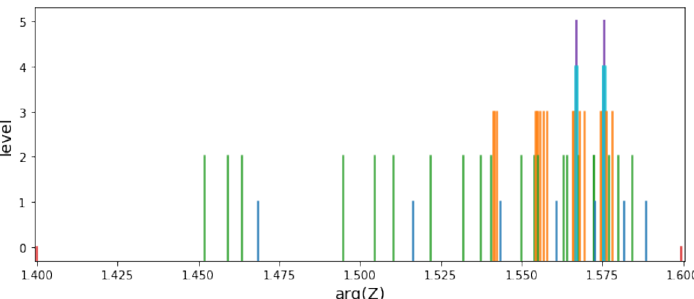
Figure 17 . States between γ and lvlcut = 5